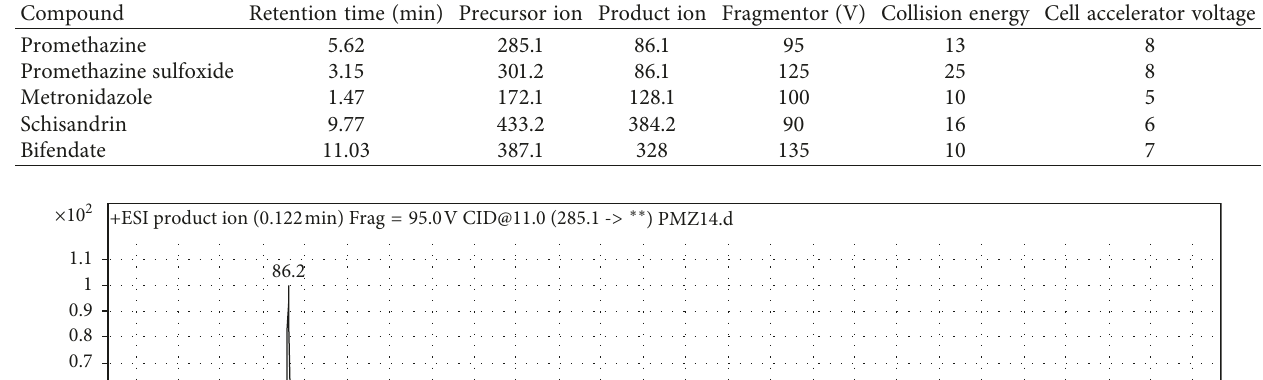
Table 1: MRM transitions, retention time, and conditions of analytes and internal standards.